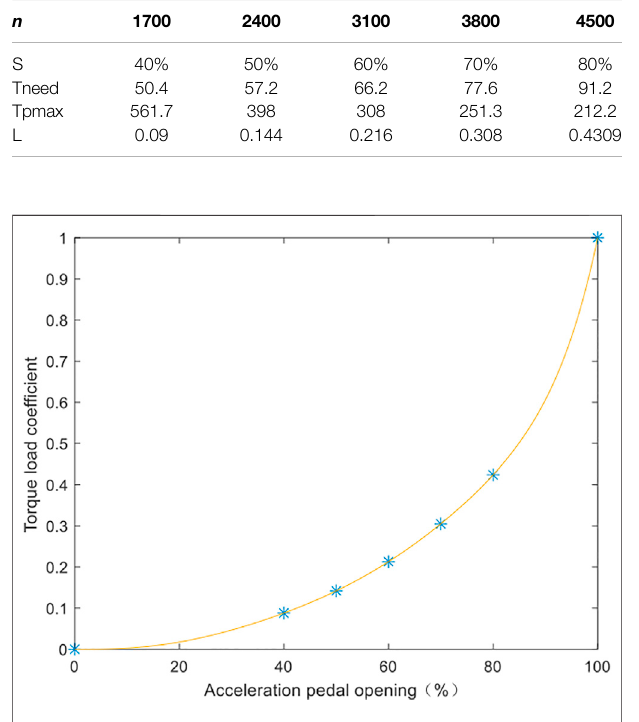
FIGURE 7 | Relationship between accelerator pedal opening S and torque load coef fi cient L.